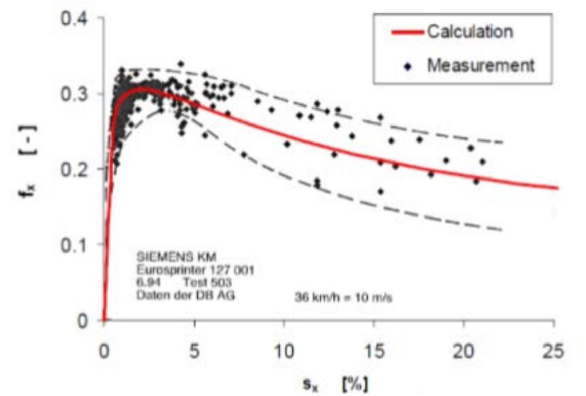
Figure 6. Comparison of measured and calculated coefficient of adhesion